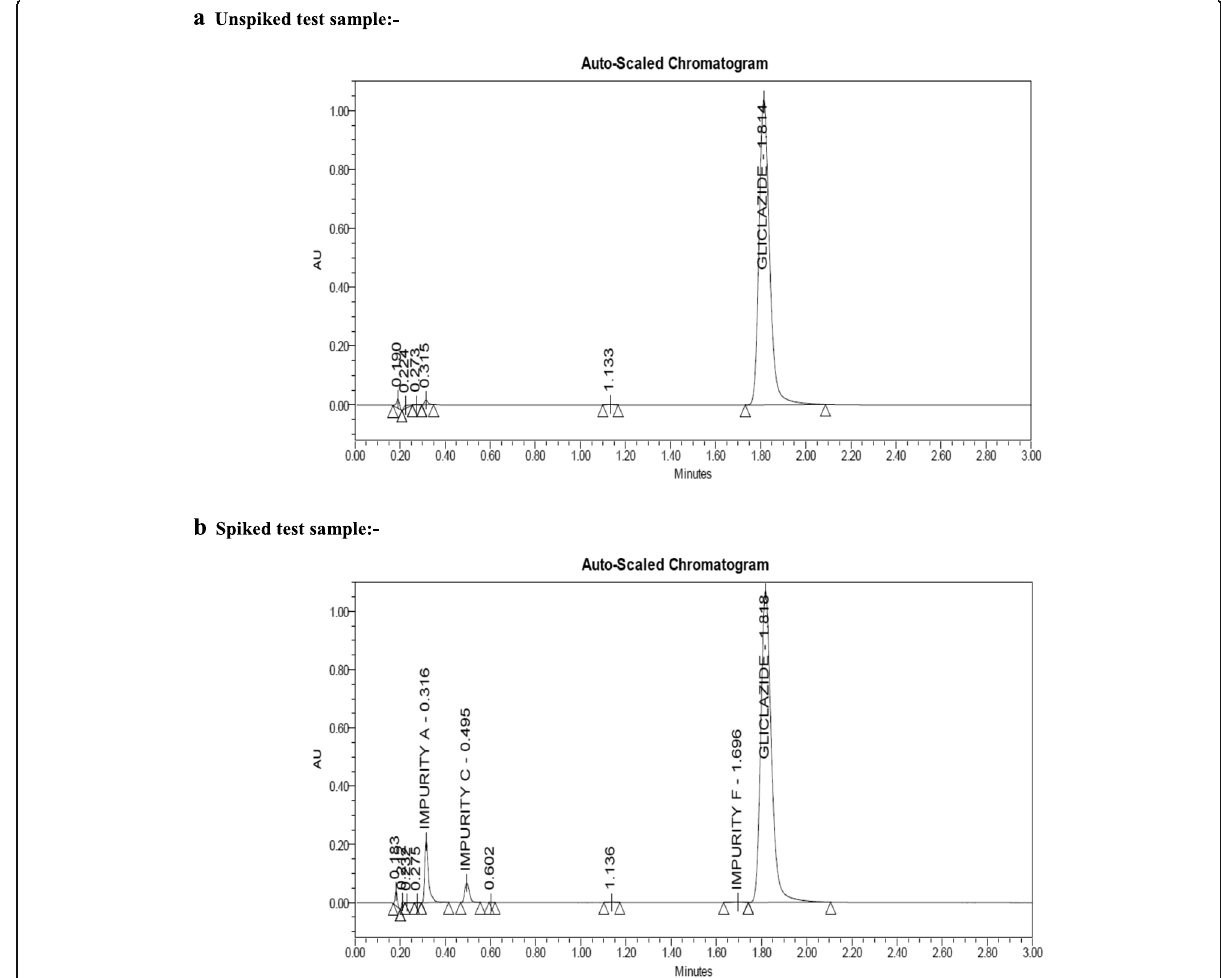
Fig. 5 UPLC chromatograms of test sample preparations. a Unspiked test sample. b Spiked test sample